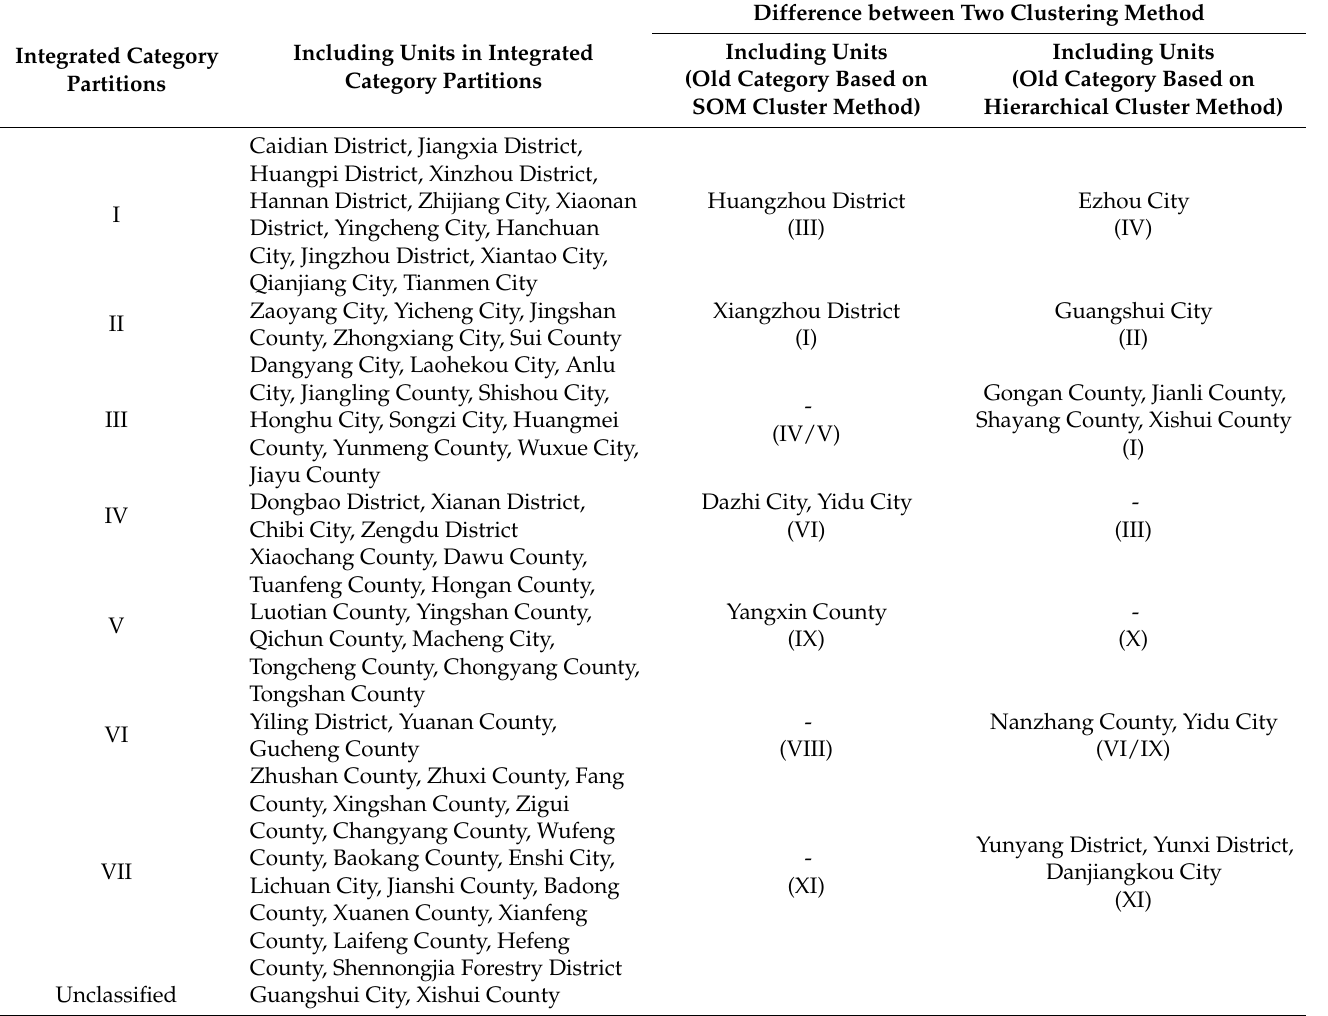
Table 4. Integrated category partitions based on comparison of two clustering